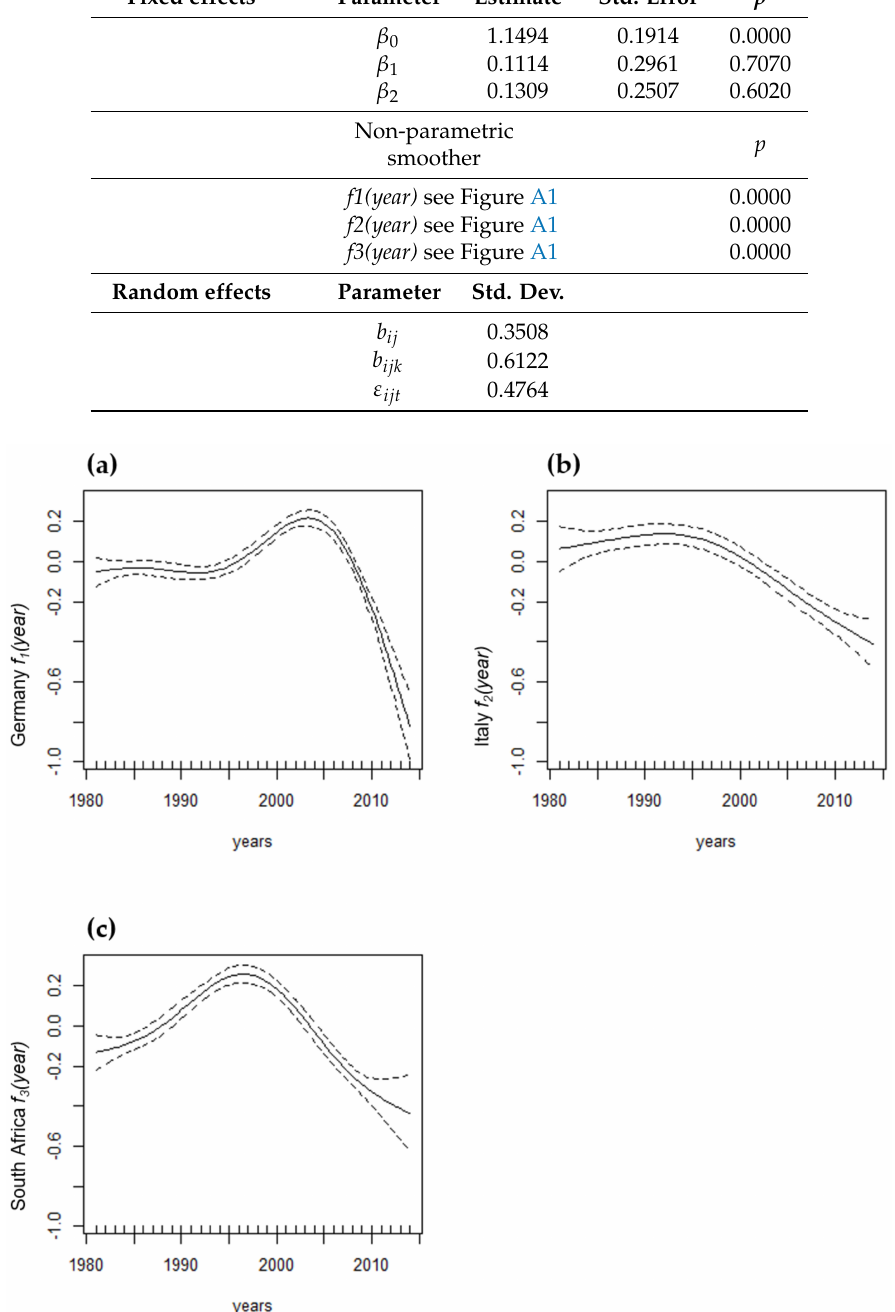
Figure A1. Generalized additive mixed effects model Equation (5) displaying the long-term growth behaviour and recent growth trends (Figure 6). The non-parametric smoothers as a function of the calendar year, i.e., (a) Germany f 1 ( year ), (b) Italy f 2 ( year ), (c) South Africa f 3